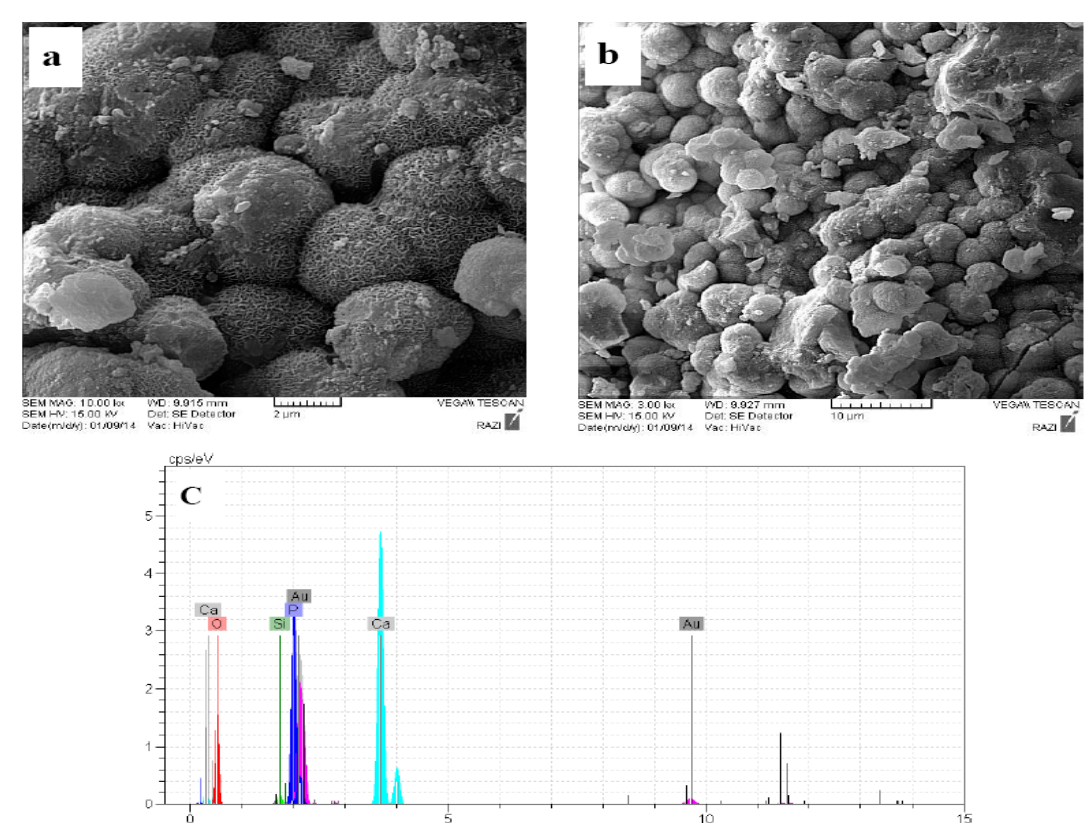
Fig. 4. SEM micrographs (a), Under higher magnification (b) and EDS patterns of akermanite powder (c) soaked in SBF for 30 days after 10 h of